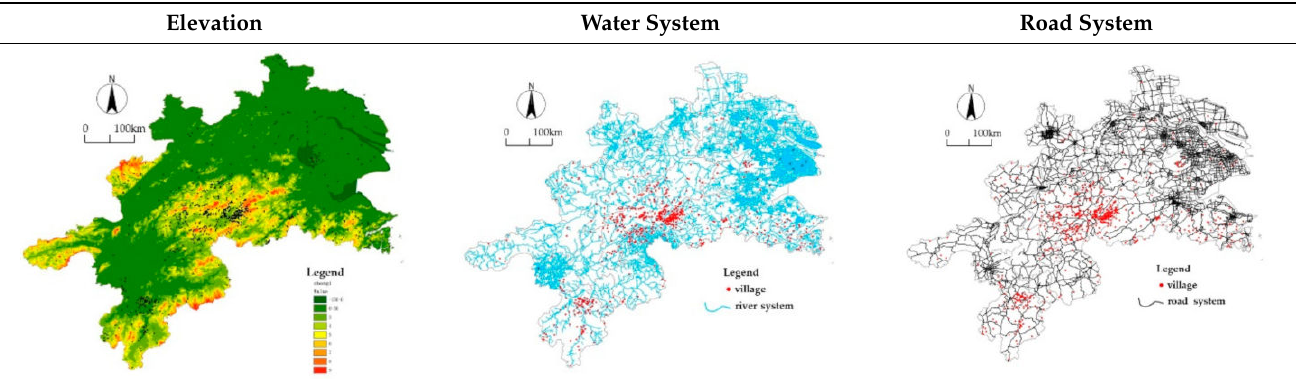
Table 6. Influencing factors of village spatial aggregation pattern: edited by